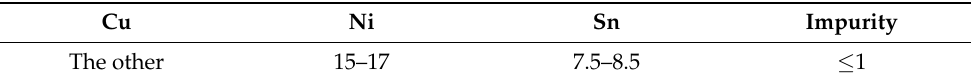
Table 4. Main element proportions of